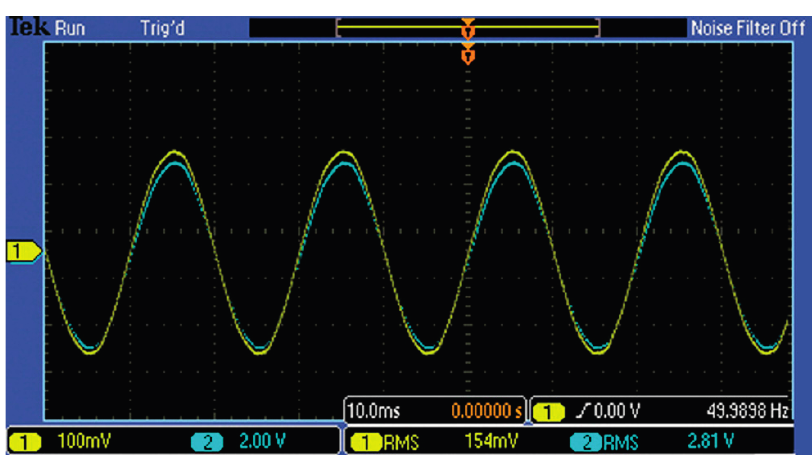
Figure 12. 5/ 3 kV AC voltage waveform